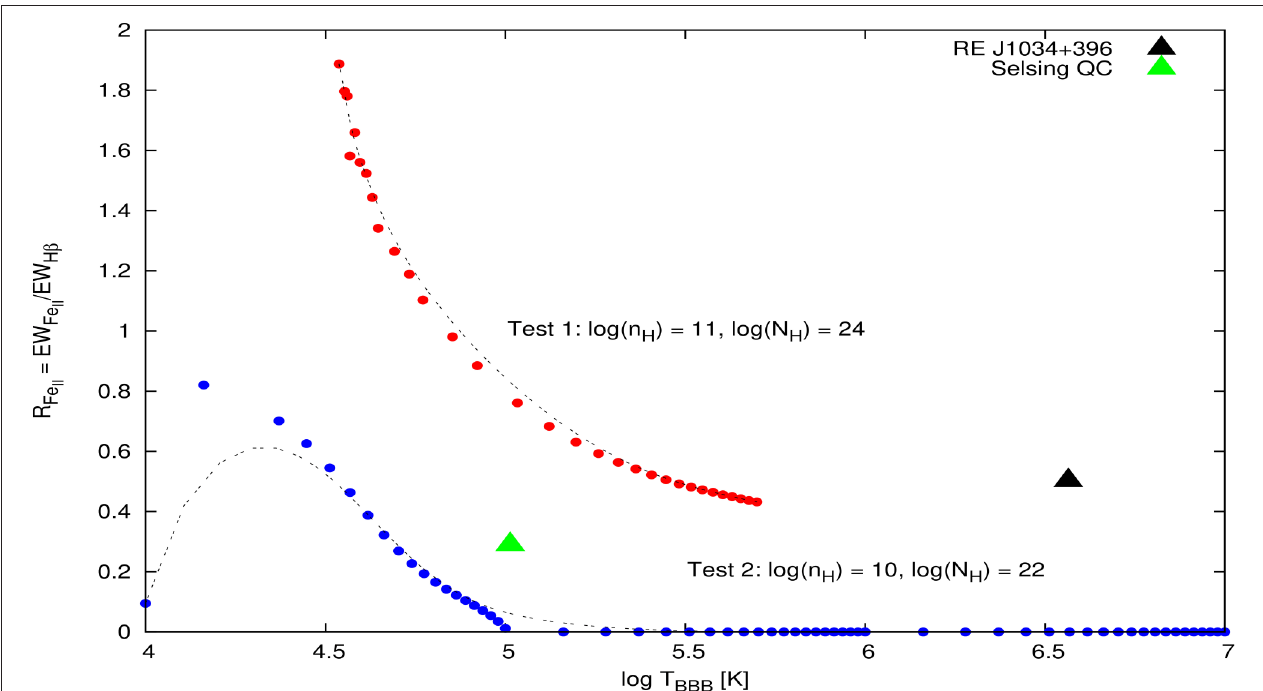
FIGURE 2 | Comparison between R FeII –T BBB for two different constant-density single cloud models. Observational data RE J1034 + 396 (Czerny et al., 2016) and Selsing quasar composite (Selsing et al., 2016) plotted on the simulated trends.